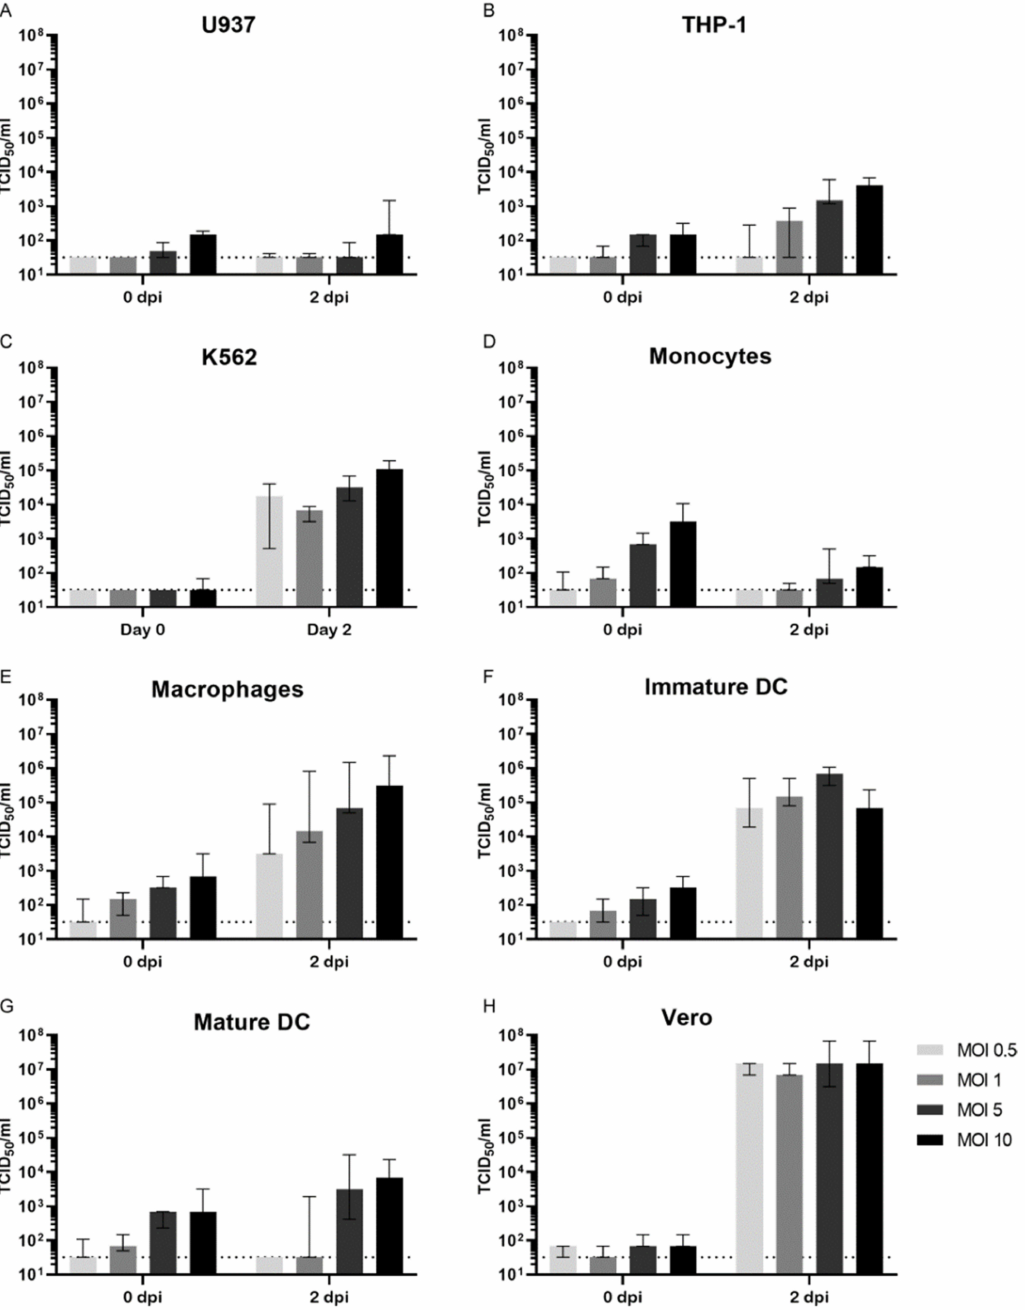
Figure 1. ZIKV infection of Fc γ R-bearing cell lines and Vero cells. Myeloid cell lines ( A – C ), primary myeloid cells ( D – G ), and Vero cells ( H ) were infected with ZIKV at different MOI’s for 48 h after which ZIKV titers were determined in supernatants. Dotted lines represent the lower limit of detection. Bars represent median ZIKV titer ± interquartile range. DC; dendritic